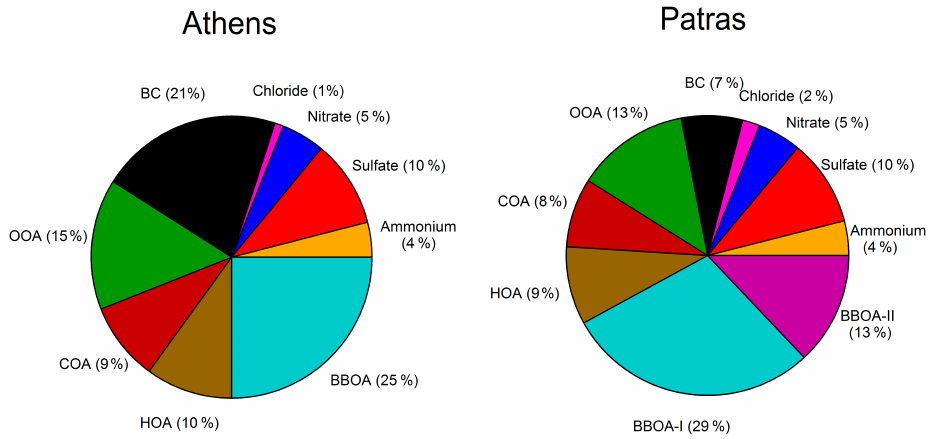
Figure 5. Average PM 1 composition and organic source apportionment for Athens and Patras. The average PM 1 for Athens was 10µgm − 3 , while for Patras it was 25µgm − 3 .